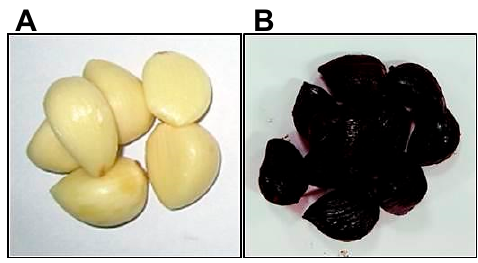
Figure 2. The colors of FRG and ABG cloves. The pure white/light yellow color of FRG ( A ) was changed to black ( B ) by heat treatment. The heating procedure was performed in a temperature and humidity controlled room for over 10 days (see Figure 1). Table 1. Comparison of contents of physicochemical components between aged black garlic (ABG) and fresh raw garlic (FRG).